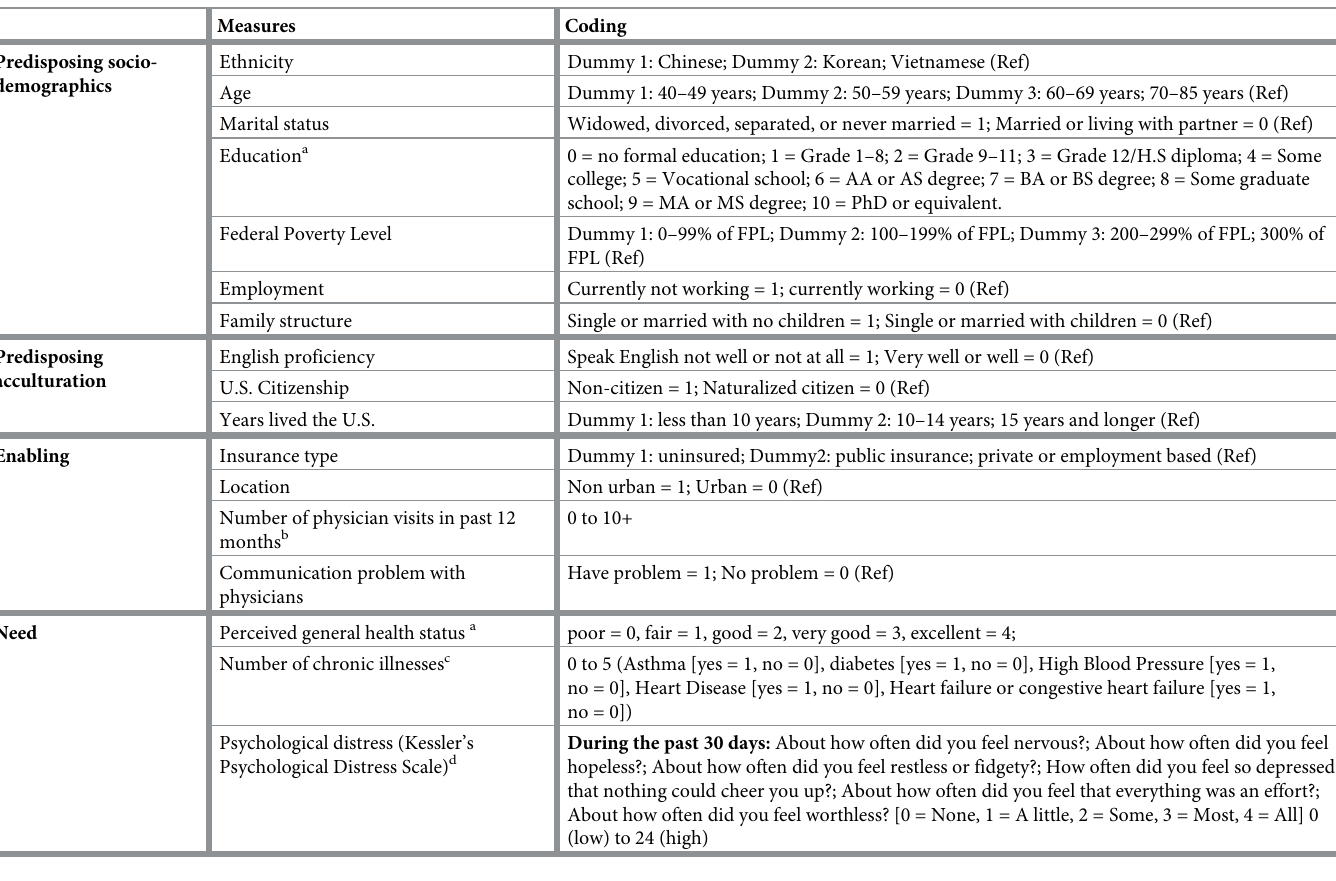
Table 1. Measures. Measures Coding Predisposing socio-